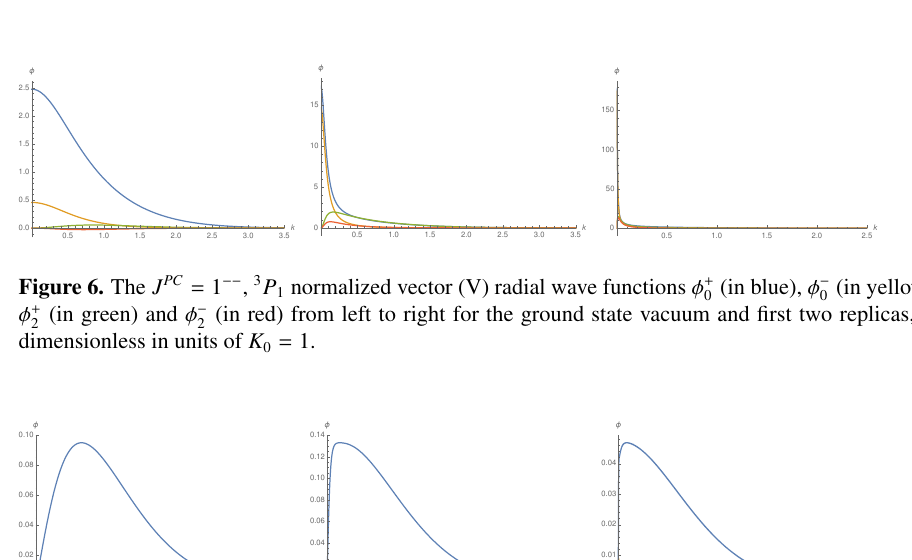
Figure 5. The J PC = 0 ++ , 3 P 0 normalized scalar (S) radial wave functions φ + (in blue) and φ − (in yellow), from left to right for the ground state vacuum and first two replicas, in dimensionless in units of K 0 = 1.